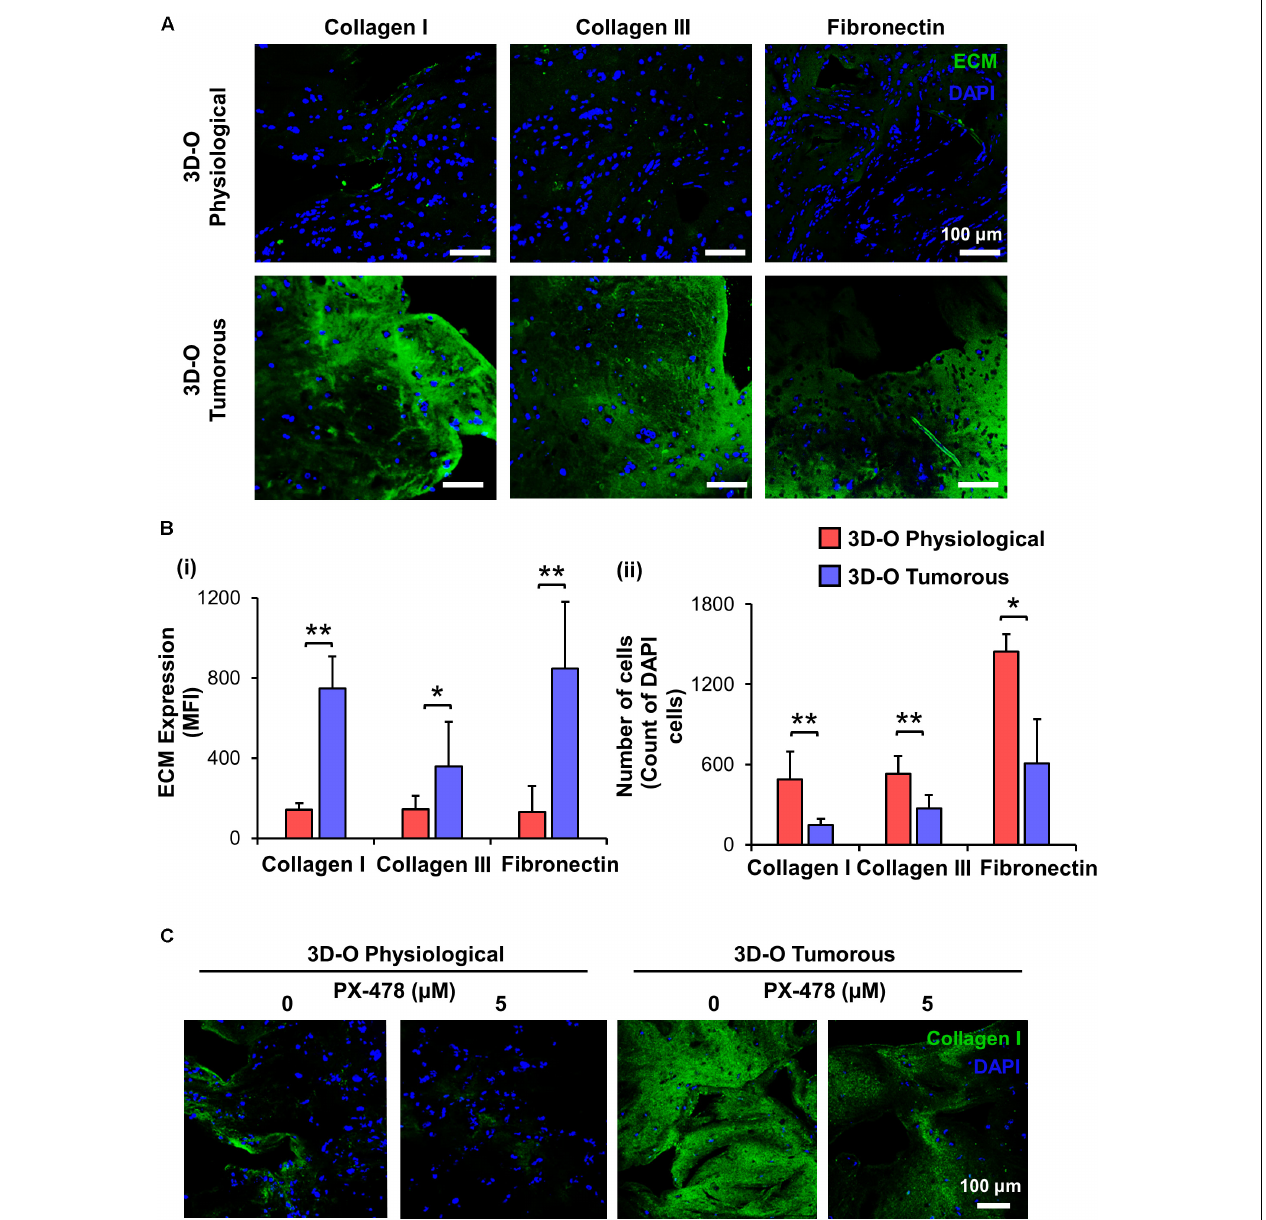
FIGURE 4 | Low-oxygen within 3D-O matrices increases the expression of main fibrous ECM proteins. (A) Representative fluorescent images exhibiting changes in expression of collagen I, collagen III, and fibronectin at day 4 for MDA-MB-231 cells grown within 3D-O physiological and 3D-O tumorous matrices; DAPI: Blue; ECMs: green). Scale bar = 100 µ m. (B) ECM expression by BCa cells growing within 3D-O physiological and 3D-O tumorous matrices, quantified as MFI of ECM expression (i) and the number of cells (ii) . (C) Representative fluorescent images exhibiting changes in collagen I expression by MDA-MB-231 cells grown in 3D-O physiological and 3D-O tumorous matrices after treatment with PX-478 for 4 days at 5 µ M concentration. Scale bar = 100 µ m. ** p < 0.001, * p < 0.05, data were analyzed using unpaired two-tailed Student’s t -test.